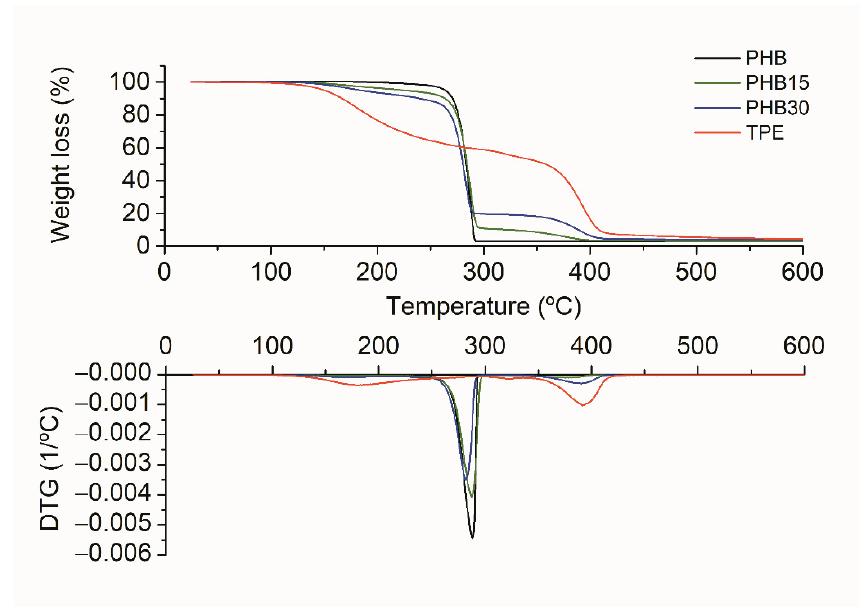
Figure 11. TGA and DTG curves of neat PHB, TPE, and PHB15 and PHB30 blends . Table 5. TGA data of PHB, TPE, and PHB/TPE 15 and 30 wt% with and without compatibilizers blends.